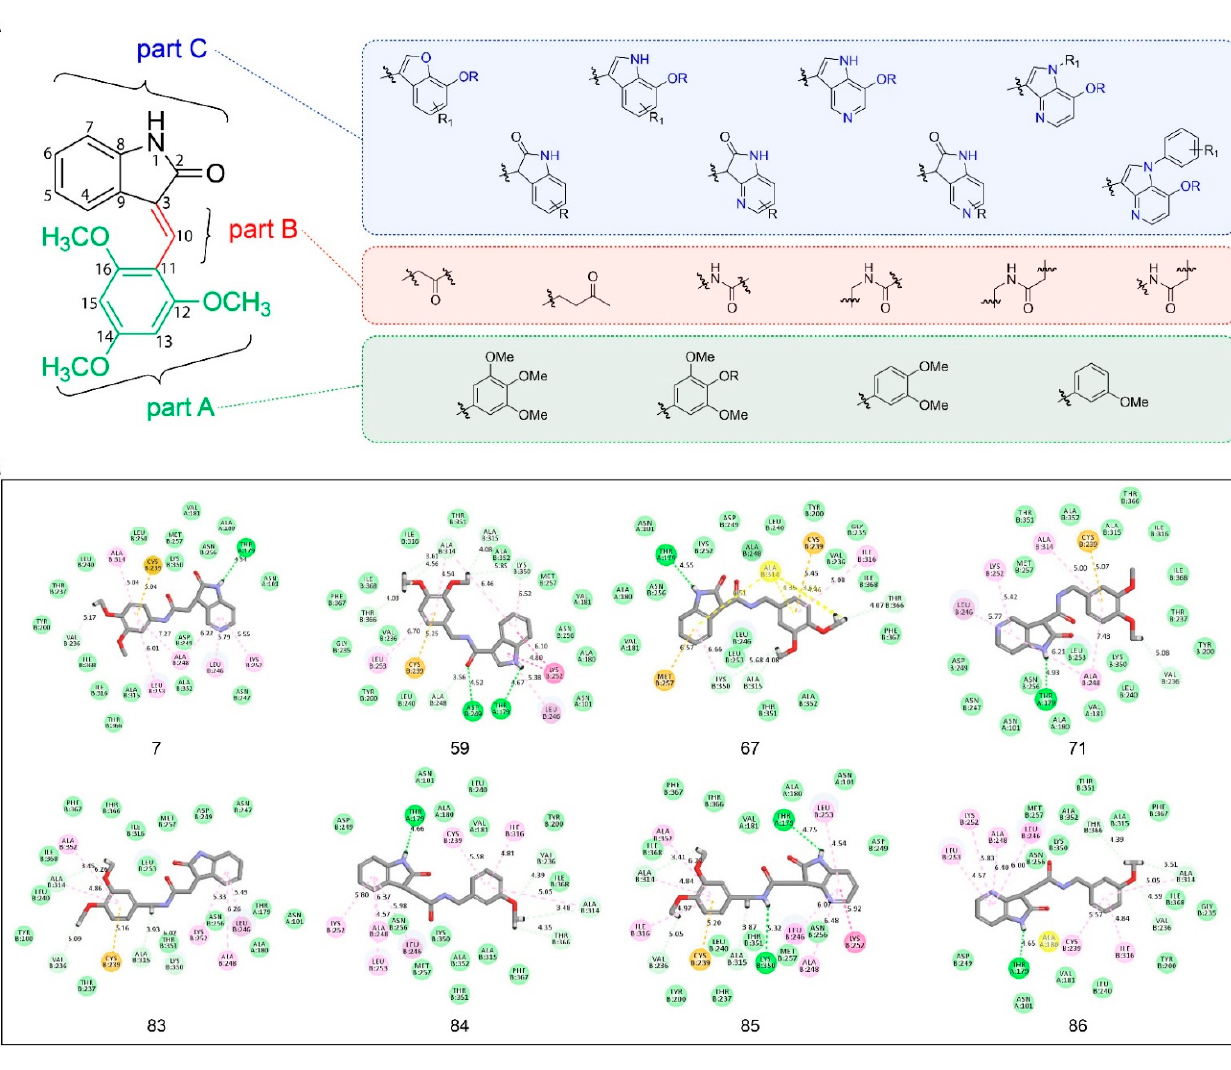
Figure 4. Insights into drug design and molecular docking studies. ( A ) IC261 molecular Design Strategy. ( B ) Three-dimensional (3D) schematic diagram of the binding model of eight candidate compounds with tubulin. The eight candidate compounds are shown as grey sticks, the oxygen atoms are shown in red, and the nitrogen atoms are shown in blue. Interactions between the molecules and amino acid residues are labeled with dotted lines, van der Waals is shown in green, carbon hydrogen bond is shown in light green, conventional hydrogen bond is shown in bottle green, pi-alkyl is shown in pink, amide-pi stacked is shown in deep pink, and pi-sulfur is shown in yellow.